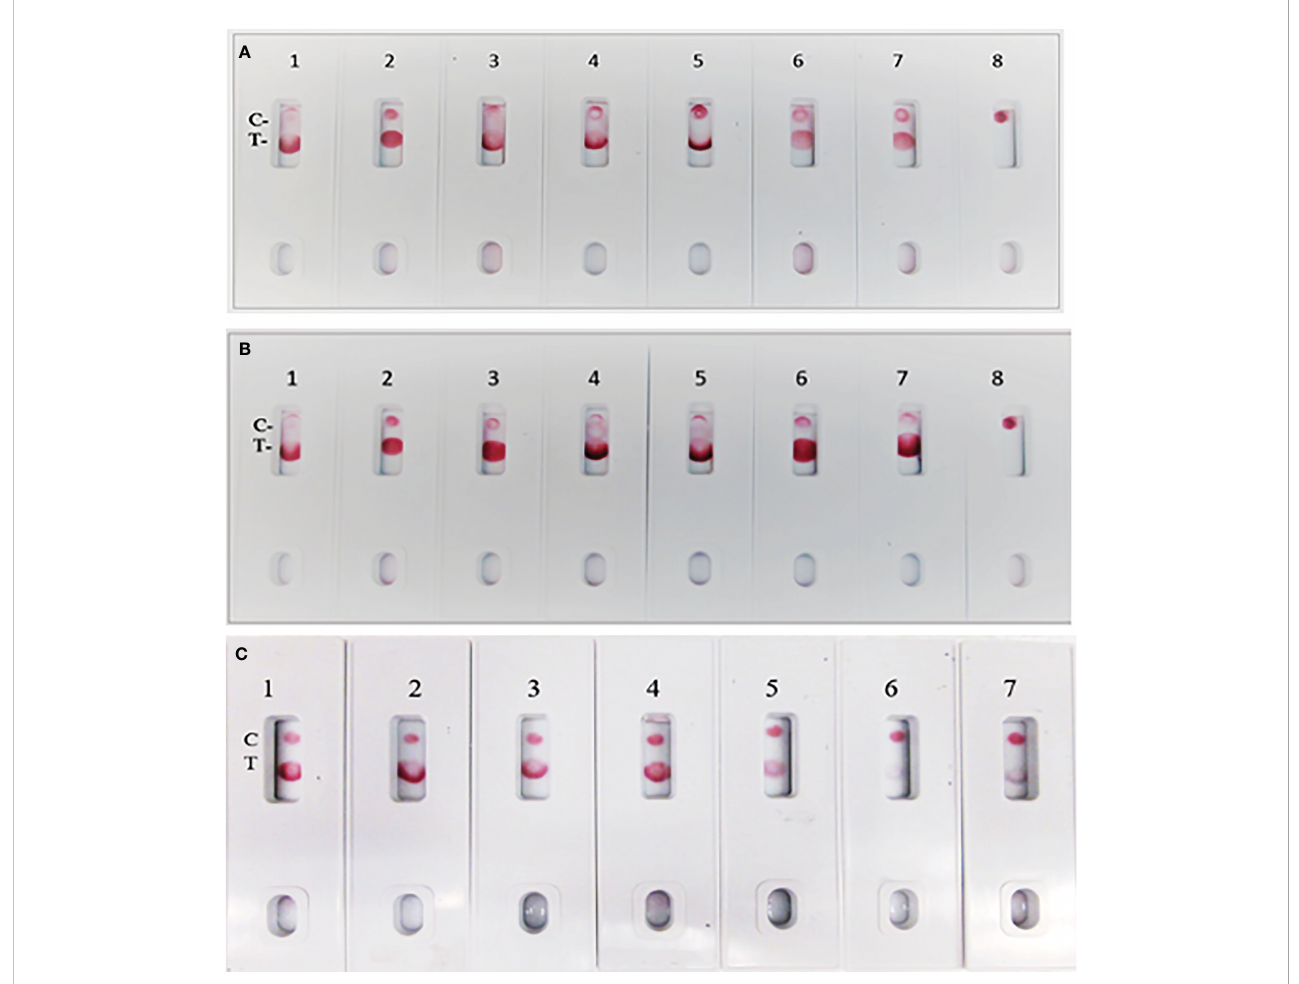
FIGURE 7 Assay speci fi city with spike protein of SARS-CoV-2 variant virus proteins. (A) 1. NR-52397 SARS-CoV-2 spike protein (positive control), 2. NR-52366 SARS-CoV-2 RBD protein (positive control), 3. NR-55614 Full-length SARS-Cov-2 Spike protein. B.1.617.2, 4. NR-55615 Full-length SARS-Cov-2 Spike protein. B.1.1.1, 5. NR-55616 Full-length SARS-Cov-2 Spike protein. A.23.1, 6. NR-53798 SARS-CoV-2 (COVID-19) S1 protein (N501Y), 7. NR-55420 SARS- CoV-2 (COVID-19) S1 protein (P681H), 8. NR-53258 Vero Cell E6 Lysate (negative control). (B) 1. NR-52397 SARS-CoV-2 spike protein (positive control), 2. NR-52366 SARS-CoV-2 RBD protein (positive control), 3. NR-55633 Spike Glycoprotein (Stabilized) from SARS-Related Coronavirus (P3), 4. NR-55614 Full-length SARS-Cov-2 Spike protein. B.1.617.2, 5. NR-55632 Full-length SARS-Cov-2 Spike protein. R.1, 6. NR-55277 Recombinant spike protein RBD, SARS-CoV-2 (UK variant), 7. NR-55278 Recombinant spike protein RBD, SARS-CoV-2 (South African variant), 8. NR-53258 Vero Cell E6 Lysate (negative control). (C) 1. NR-52397 Spike SARS-CoV-2 stabilized protein (positive control), 2. NR-52366 SARS-CoV-2 RBD Protein (positive control), 3. NR-55307 stabilized spike trimer SARS-CoV-2 (P.1), 4. NR-55310 stabilized spike trimer SARS-CoV-2 (B.1.351), 5. NR-55311 stabilized spike trimerSARS-CoV-2 (B.1.1.7), 6. NR-55438 stabilized spike trimerSARS-CoV-2 (B.1.526), 7. NR-53258 Vero Cell E6 Lysate (negative